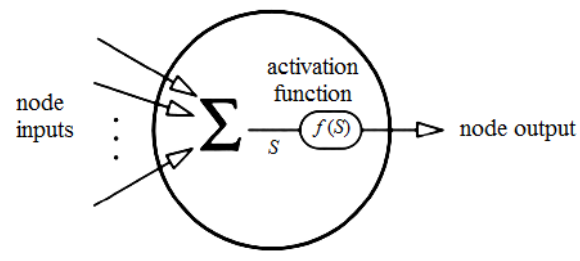
Figure 2. The components of a neuron